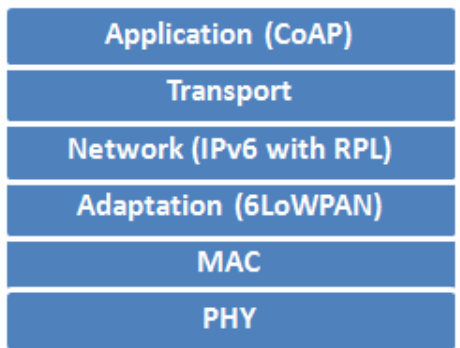
Figure 16. IETF LLN protocol